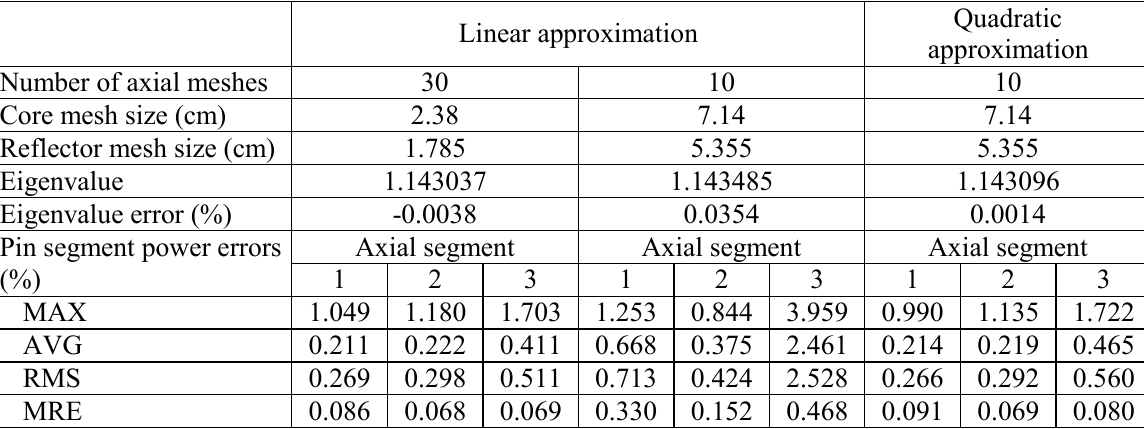
Table I. Eigenvalue and pin-segment power errors of PROTEUS-MOC solutions obtained with linear and quadratic approximations relative to MCNP reference solution